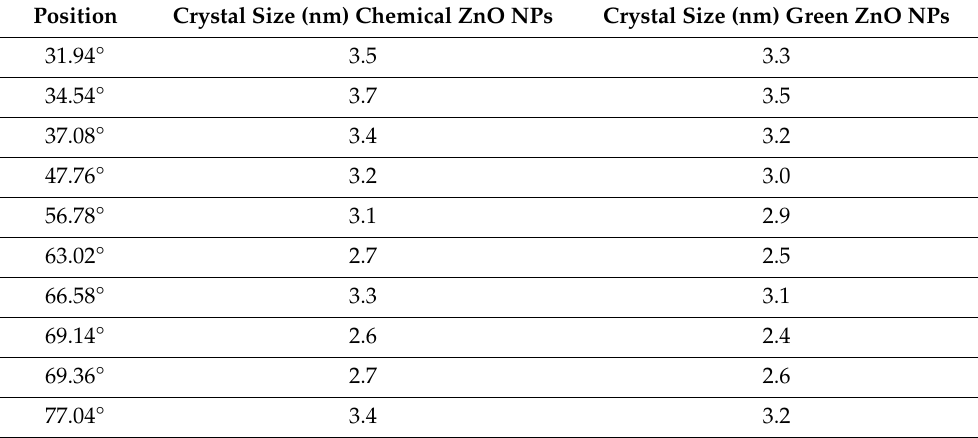
Table 2. The calculated crystal size of green and chemically synthesized ZnO NPs.